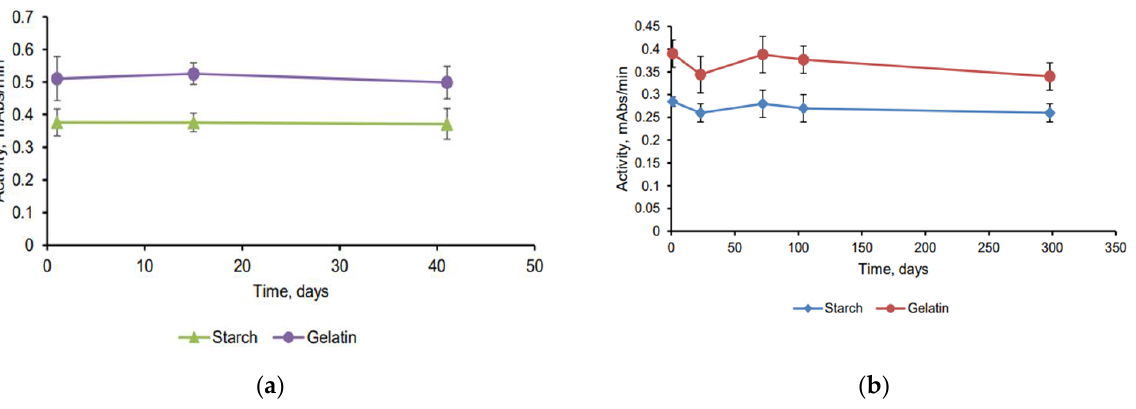
Figure 3. Activities of preparations with immobilized BChE vs. storage time: ( a ) activity of BChE (0.11 U) immobilized in 3% starch gel or 1.4% gelatin gel; ( b ) activity of the preparation with co- immobilized BChE (0.11 U) and 0.2 mM DTNB.